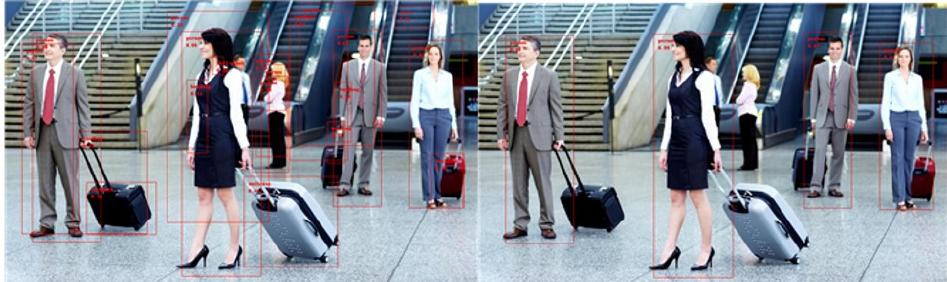
Figure 3. Change of Detection Accuracy depending on the IoU threshold. Threshold is 0 ( left ) and 0.5 ( right ).